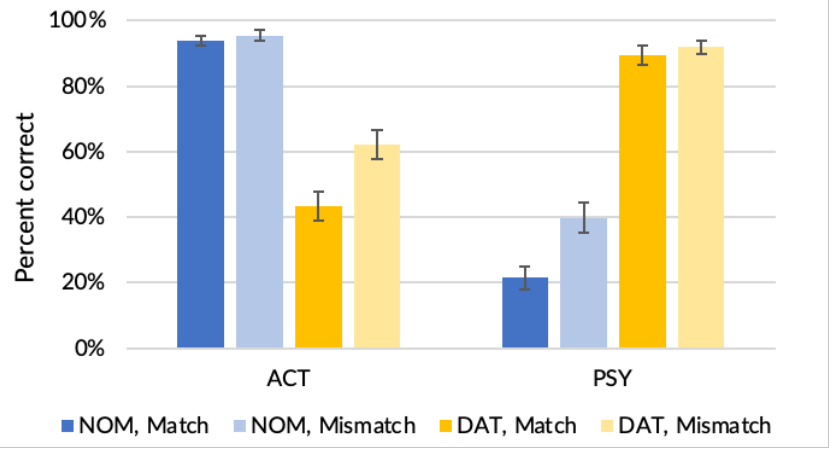
Figure 6. Results from child group by verb type, extraction site, and number